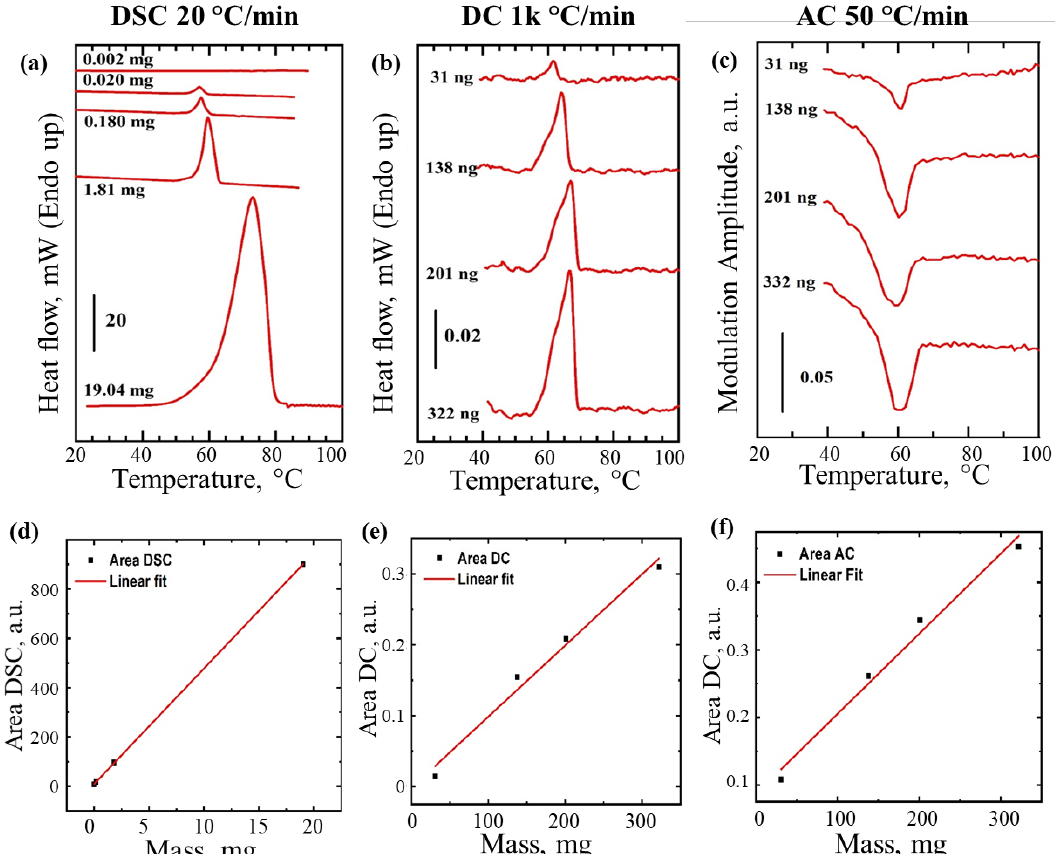
Figure 5. Analysis of polyethylene glycol (PEG) in DC and AC modes. Heat flow vs. sample